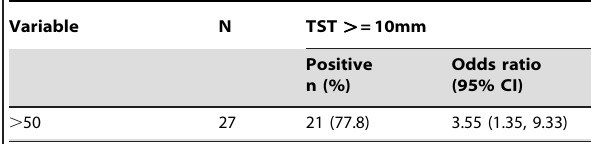
Table 5. Association between measures of current and past TB exposure and TST positivity: Results of univariate logistic regression.